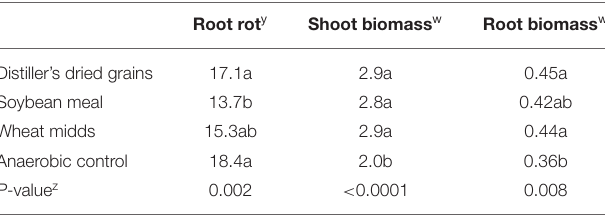
TABLE 5 | Impacts of anaerobic soil disinfestation (ASD) on root rot severity, root biomass, and shoot biomass in post-ASD bioassays using soils collected from plots treated in on-farm trials.